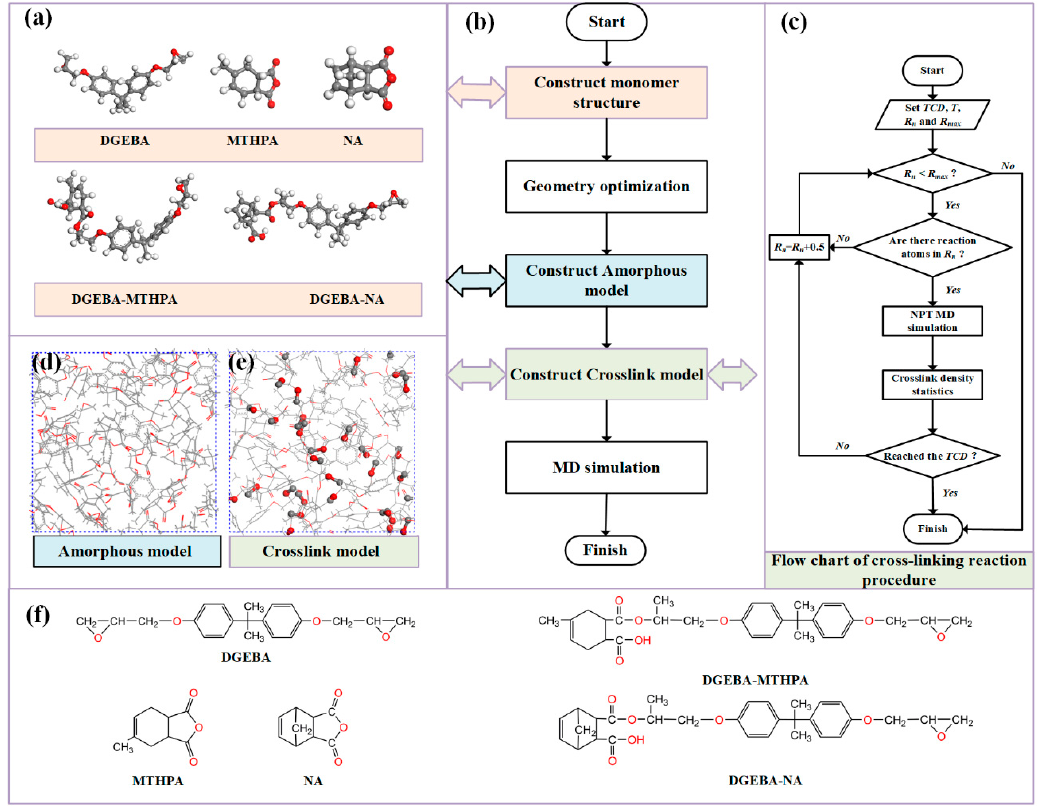
Figure 2. Establishment of molecular models. ( a ) Molecular structure of DGEBA, MTHPA, NA, DGEBA-MTHPA and DGEBA-NA; ( b ) flow diagram of construction; ( c ) flow chart of crosslinking reaction program; ( d ) amorphous model, ( e ) crosslink model; ( f ) molecular formulas of DGEBA, MTHPA, NA, DGEBA-MTHPA and DGEBA-NA.